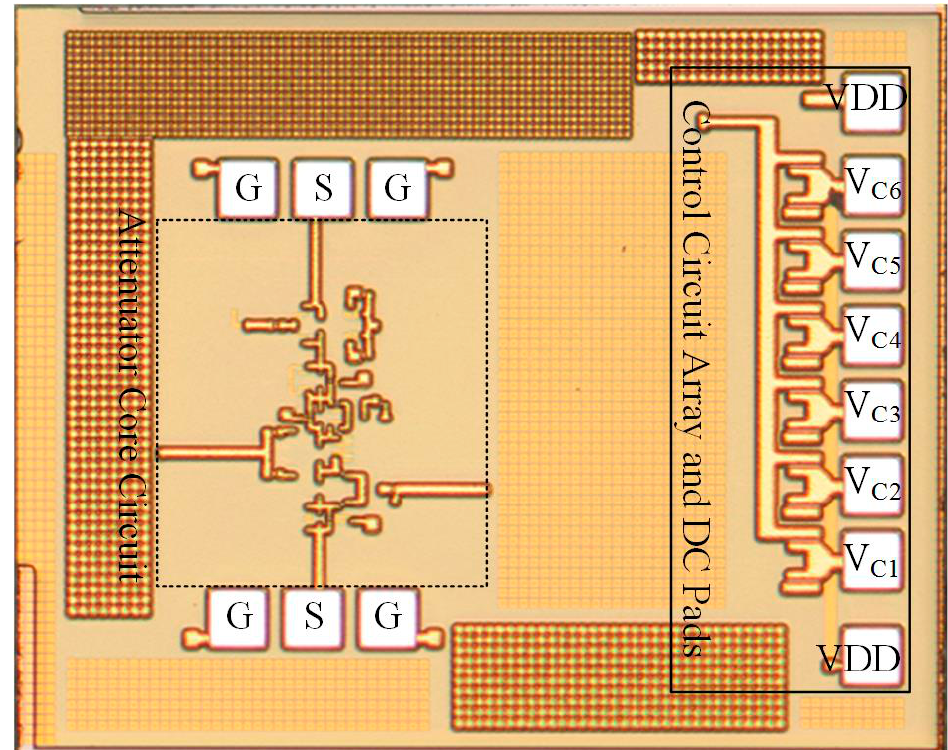
Figure 10. The die photograph of the proposed 6-bit digital control step attenuator.